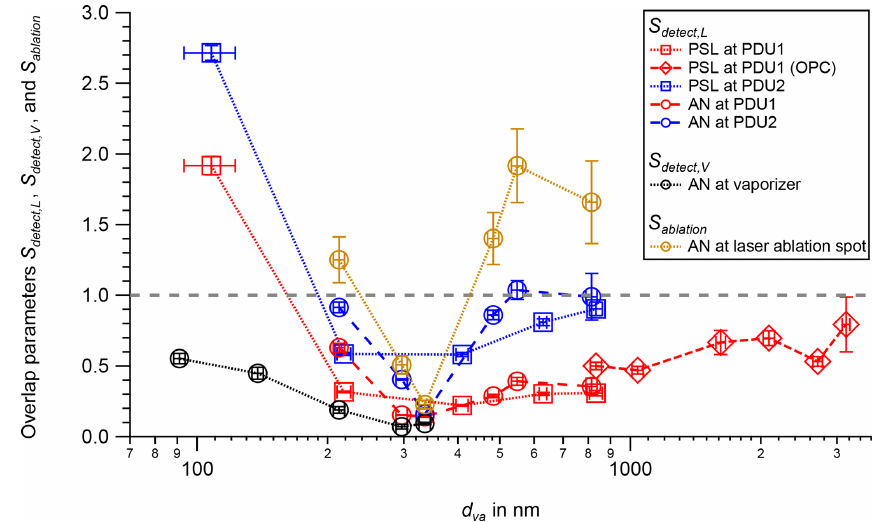
Figure 5. The overlap parameters S detect , L , S detect , V , and S ablation as a function of particle size d va for PSL (squares) and AN (circles) particles. S detect , L was determined for PSL and AN particles at PDU1 (red) and PDU2 (blue). S detect , V was determined for AN particles at the ERICA-AMS vaporizer (black). S ablation was calculated for AN particles at the laser ablation spot (brown). CPC and OPC measurements are as for Fig. 3. The horizontal dashed gray line illustrates where the ratio equals 1. The uncertainties in S detect , L , S detect , V , and S ablation result from the curve-fitting values (1 standard